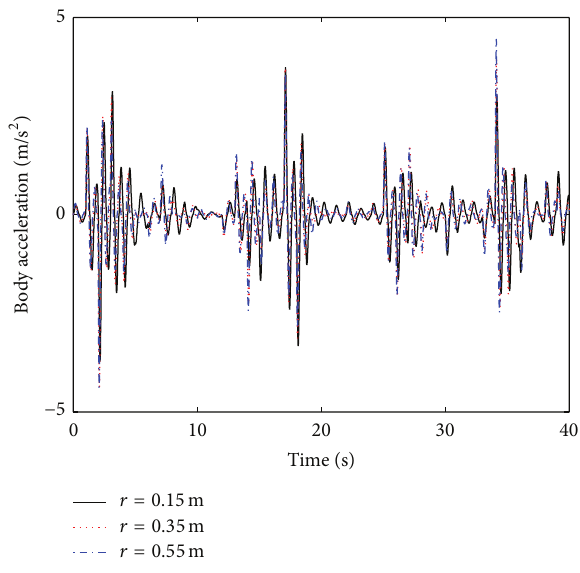
Figure 6: Acceleration of the sprung mass of different wheel